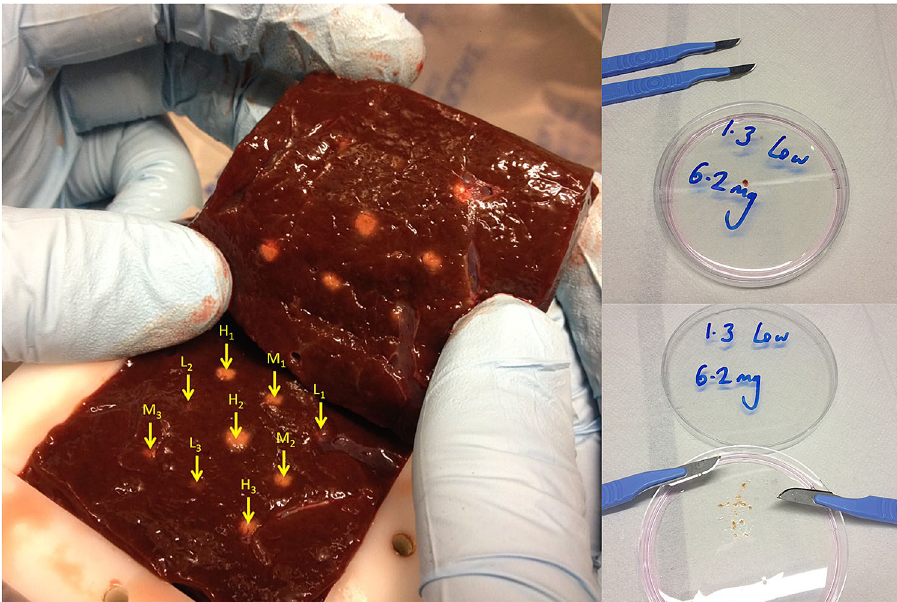
Figure 2. Experimental images of ablated ex-vivo bovine liver. LEFT: N = 3 HIFU lesions for each of H = High = 8.2 MPa (peak-to-peak), M = Medium = 7.3 MPa and L = Low = 6.3 MPa acoustic pressures obtained in freshly harvested degassed ex vivo bovine liver. Liver tissue remains in watertight tissue holder with the acoustic window removed and has been sliced transversely at the axial focus (2 cm depth). Lesions for each pressure regime are staggered across rows to help locate the (more subtle) low power lesions relative to the other lesions. RIGHT: A biopsy sample of 6.2 mg liver mass exposed to low HIFU pressures obtained from the L1 lesion before (TOP) and after (BOTTOM) physical disaggregation using crossed scalpels in petri dish, prior to enzymatic